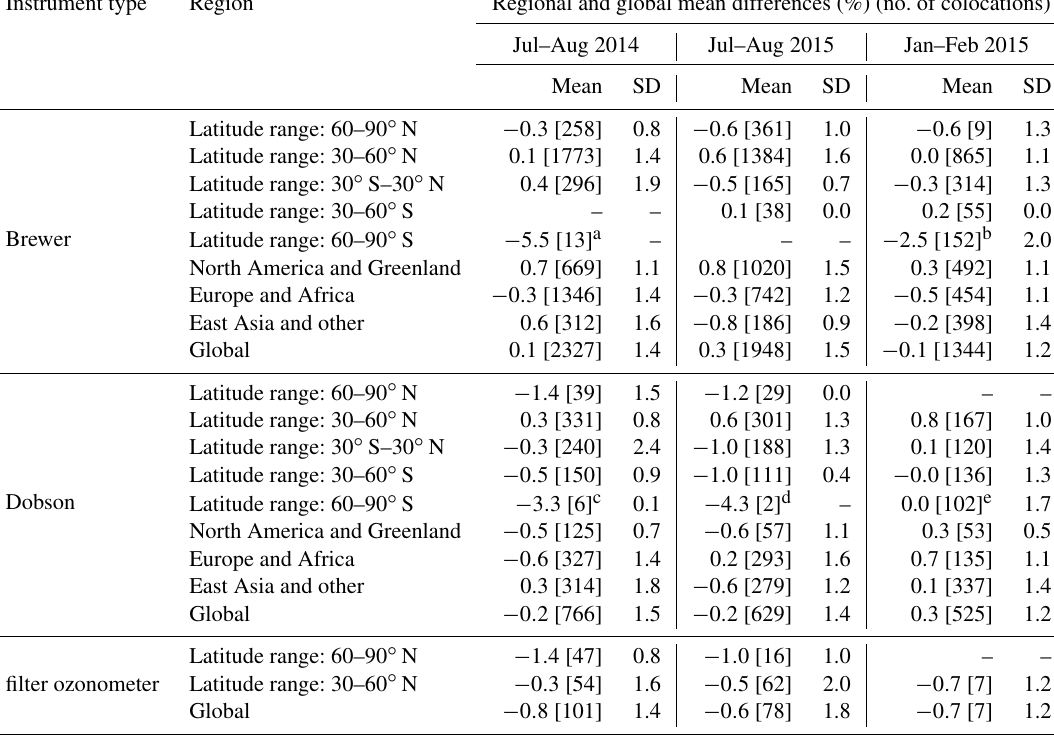
Table 1. Regional and global relative mean differences (%) of total column ozone between OMI-TOMS and the specified ground-based instrument types over July–August 2014/2015 and January–February 2015. The averaging excludes stations having outlier station mean differences for each period (see Supplement tables S1 to S3 and the text of Sect. 3), except for the two rows for the latitude region 60–90 ◦ S as described in the text. The standard deviations (SDs) are for the inter-station variation of the mean differences about the regional or global mean differences. Unavailable SD values for available mean differences imply the presence of only one station. The Dobson total column ozone measurements for the two July–August periods were adjusted as a function of the ozone effective temperature (see Sect. 2.4); those for the January–February period were not adjusted in the absence of the ozone effective temperature for the period. The impacts of the Dobson July–August period corrections on the global mean differences were reductions between 0.0% and